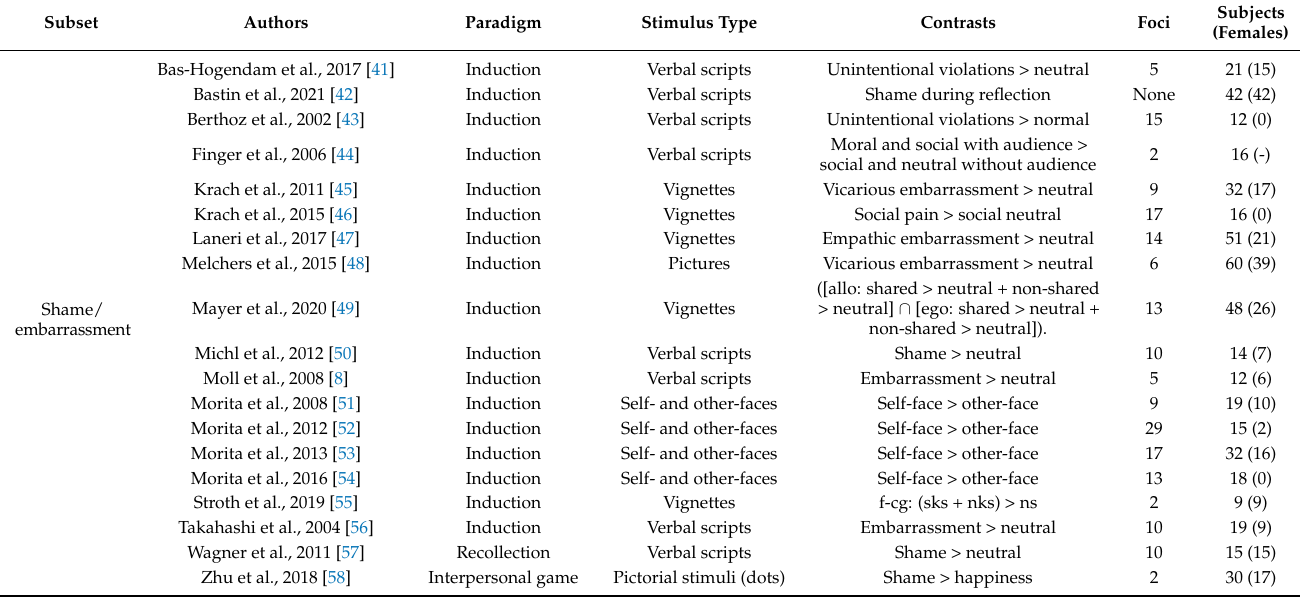
Table 2. Studies investigating shame/embarrassment and guilt brain